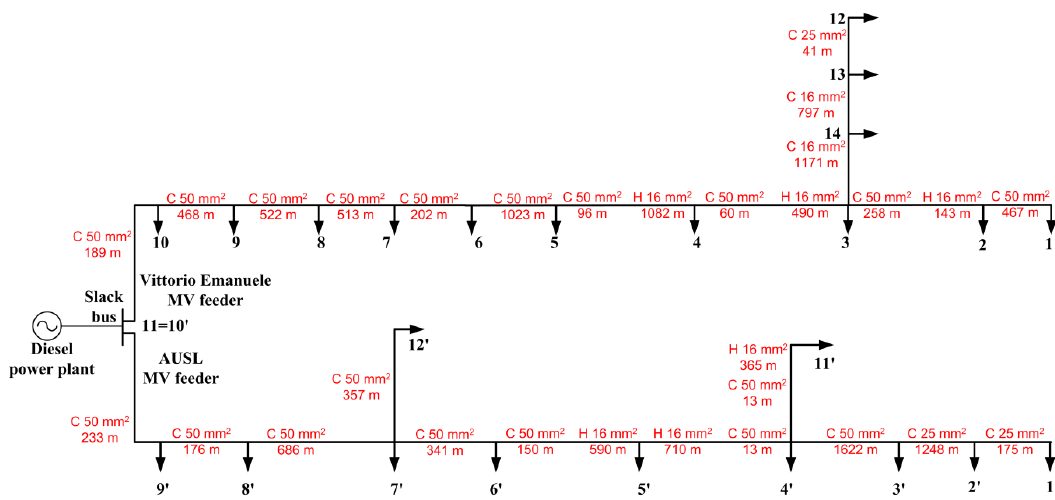
Figure 4 . Circuit diagram of the Ustica MV network: the type (C = cable, H = overhead), the core section and the length are reported for each MV line.